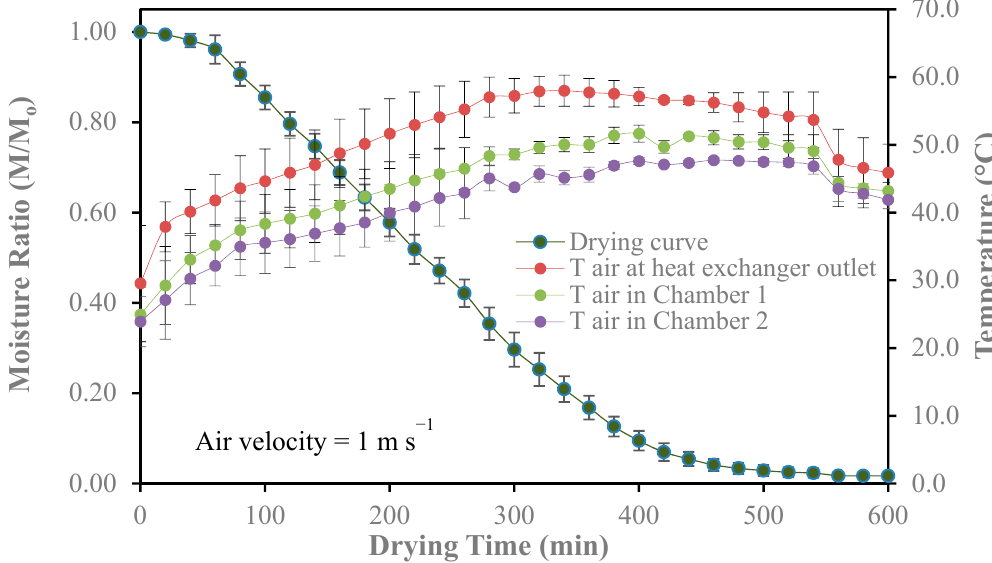
Figure 2. Relationship between the moisture ratio and the drying time and the air temperature versus drying time for the two drying chambers and heat exchanger outlet (mean values of the three runs performed).